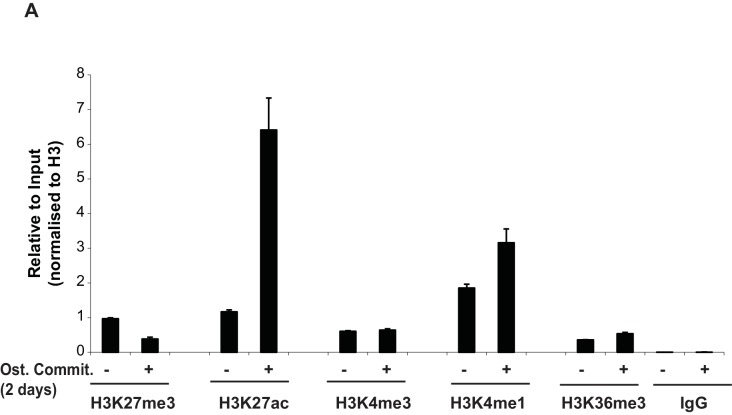
(A) ChIP-QPCR at another PLZF peak observed within the ZBTB16 locus showing enrichment of histone marks (H3K27ac, H3K4me1, H3K4me3 and H3K36me3) in naive hMSCs or in pre-osteoblasts (at day 2 of osteogenic differentiation).QPCR data is shown as mean values ± SD of triplicates from three biological replicates. Region amplified by QPCR corresponds to the primer D shown in Figure 1D. General IgG was used as negative control.